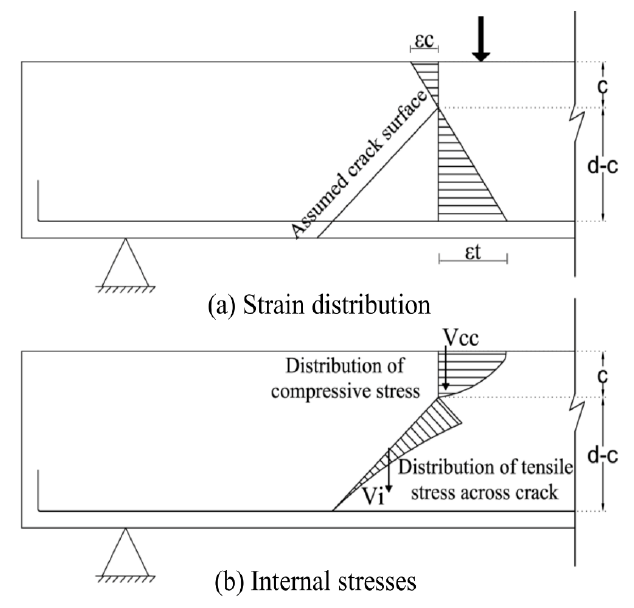
Figure 13. Schematic of assumed strain distribution and internal stresses in shear span of a beam (adapted from [65]).